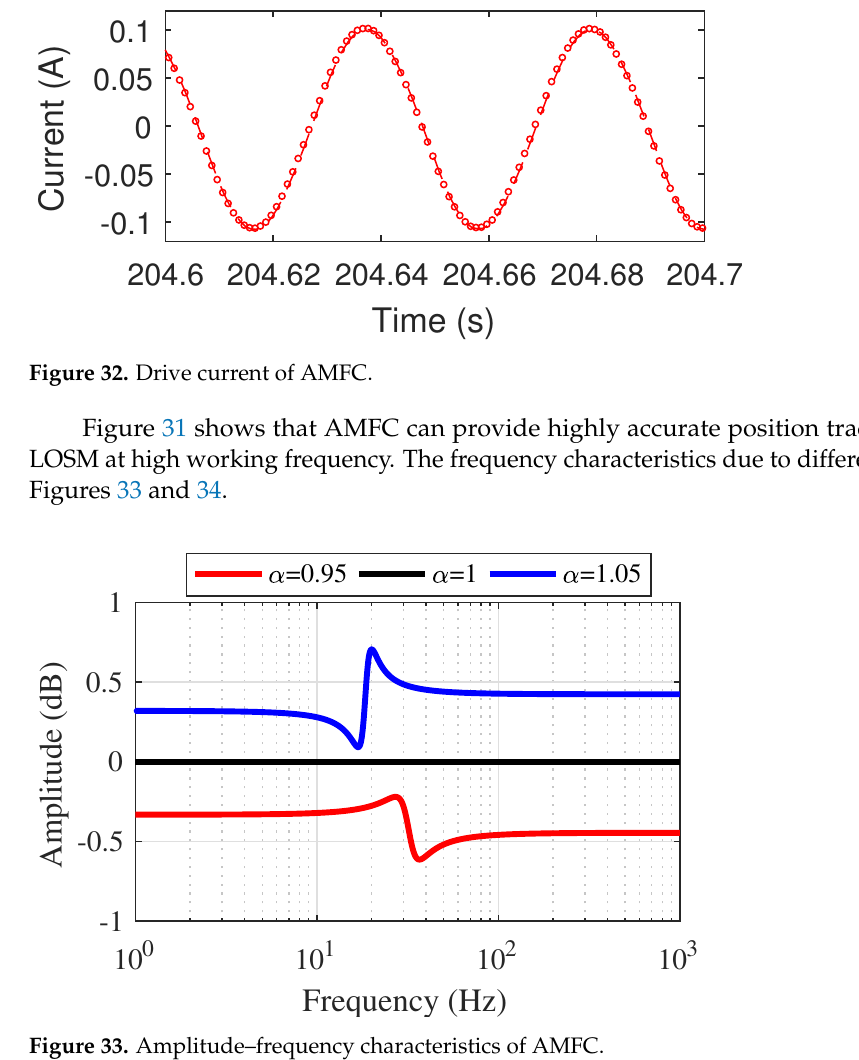
Figure 33. Amplitude–frequency characteristics of AMFC.